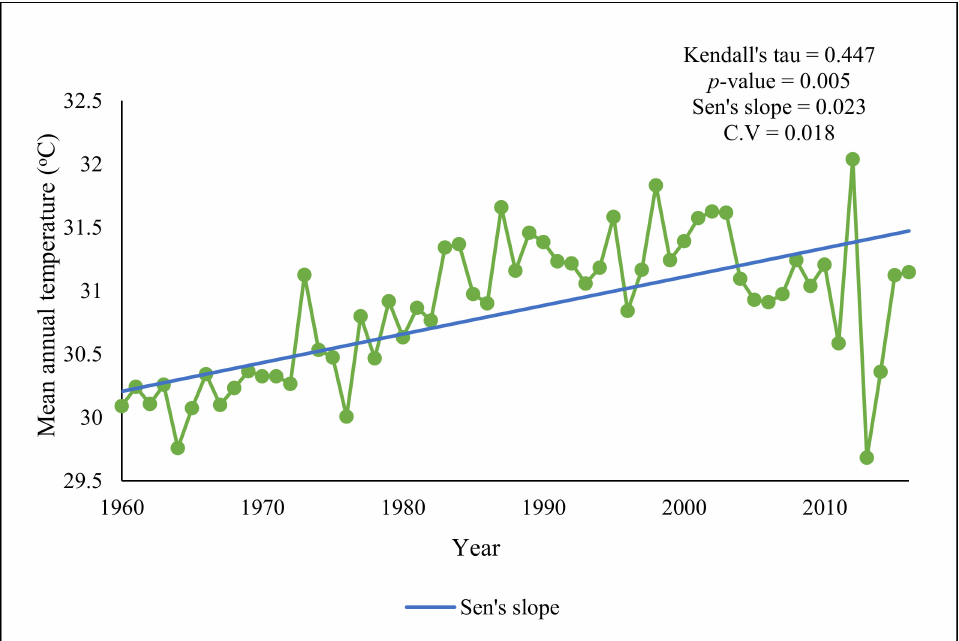
Figure 3. Mean annual temperature of study area, 1960–2016. Source: Data obtained from Council for Scientific and Industrial